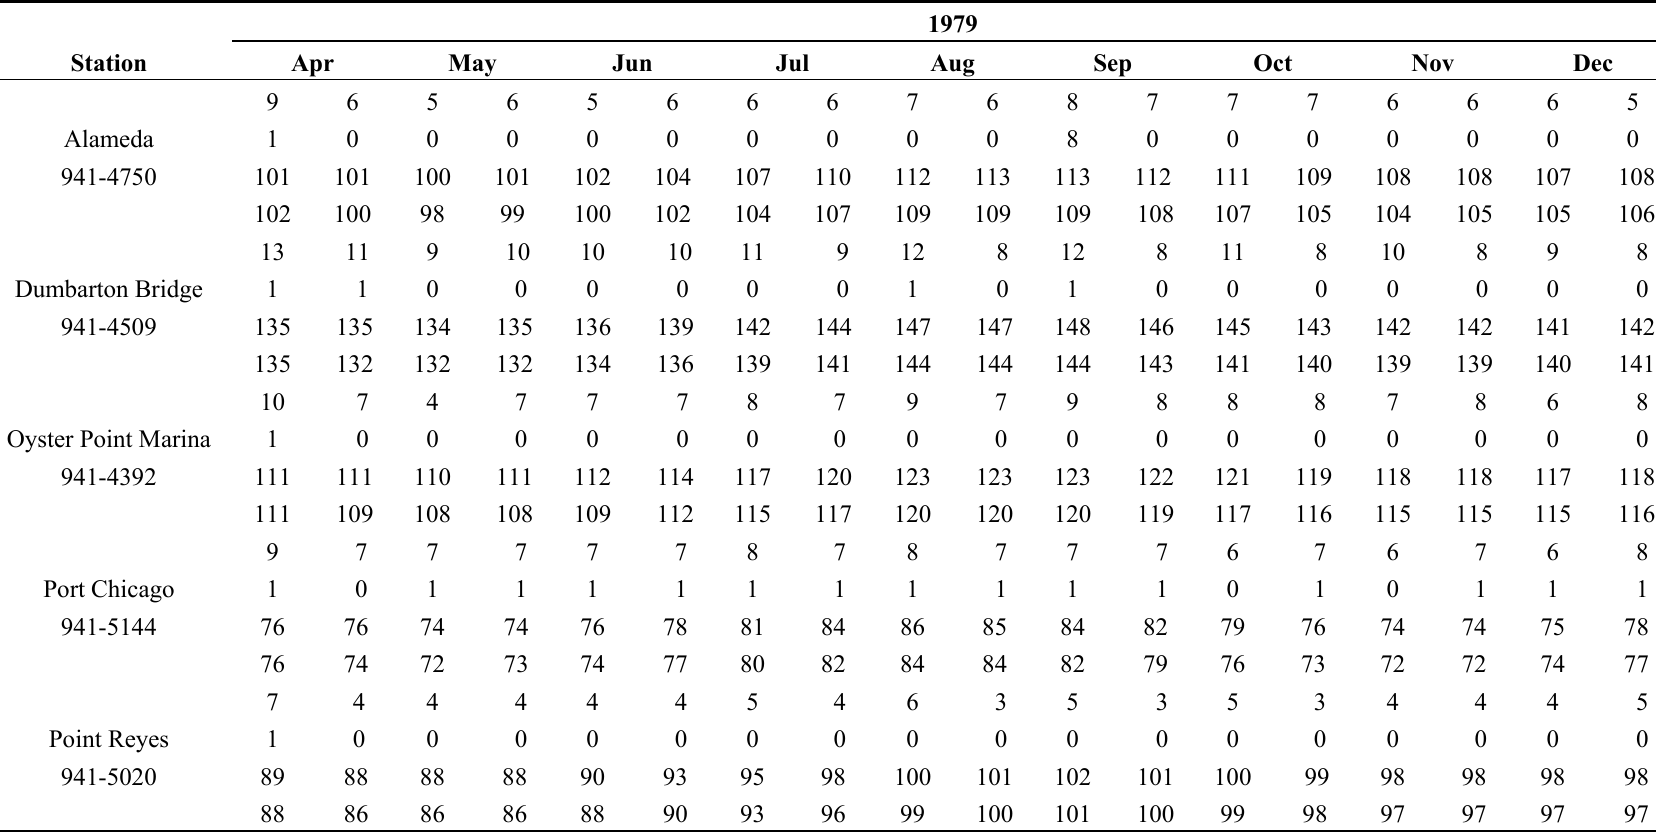
Table 3. Water Surface Elevation Tidal Calibration: April 1979–October 1980. For each box, the first column of values corresponds to the first 15 days of the month, with the second column of values denoting the remaining portion of the month. Within each column: Row 1 corresponds to the RMSE in cm. Row 2 corresponds to the Willmott Relative Error in percent. Row 3 corresponds to the model mean in cm with respect to MLLW with Row 4 denoting the predicted water level mean in cm relative to